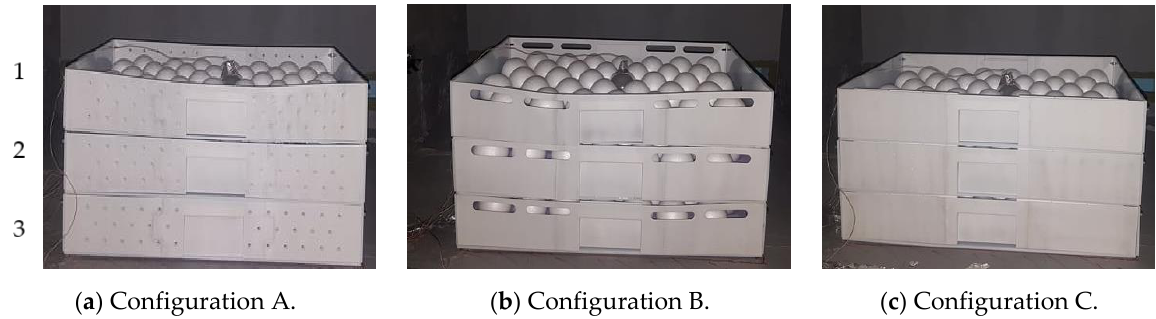
Figure 7. Configurations tested and box numbering: a) Configuration A; b) configuration B; c) Configuration C.